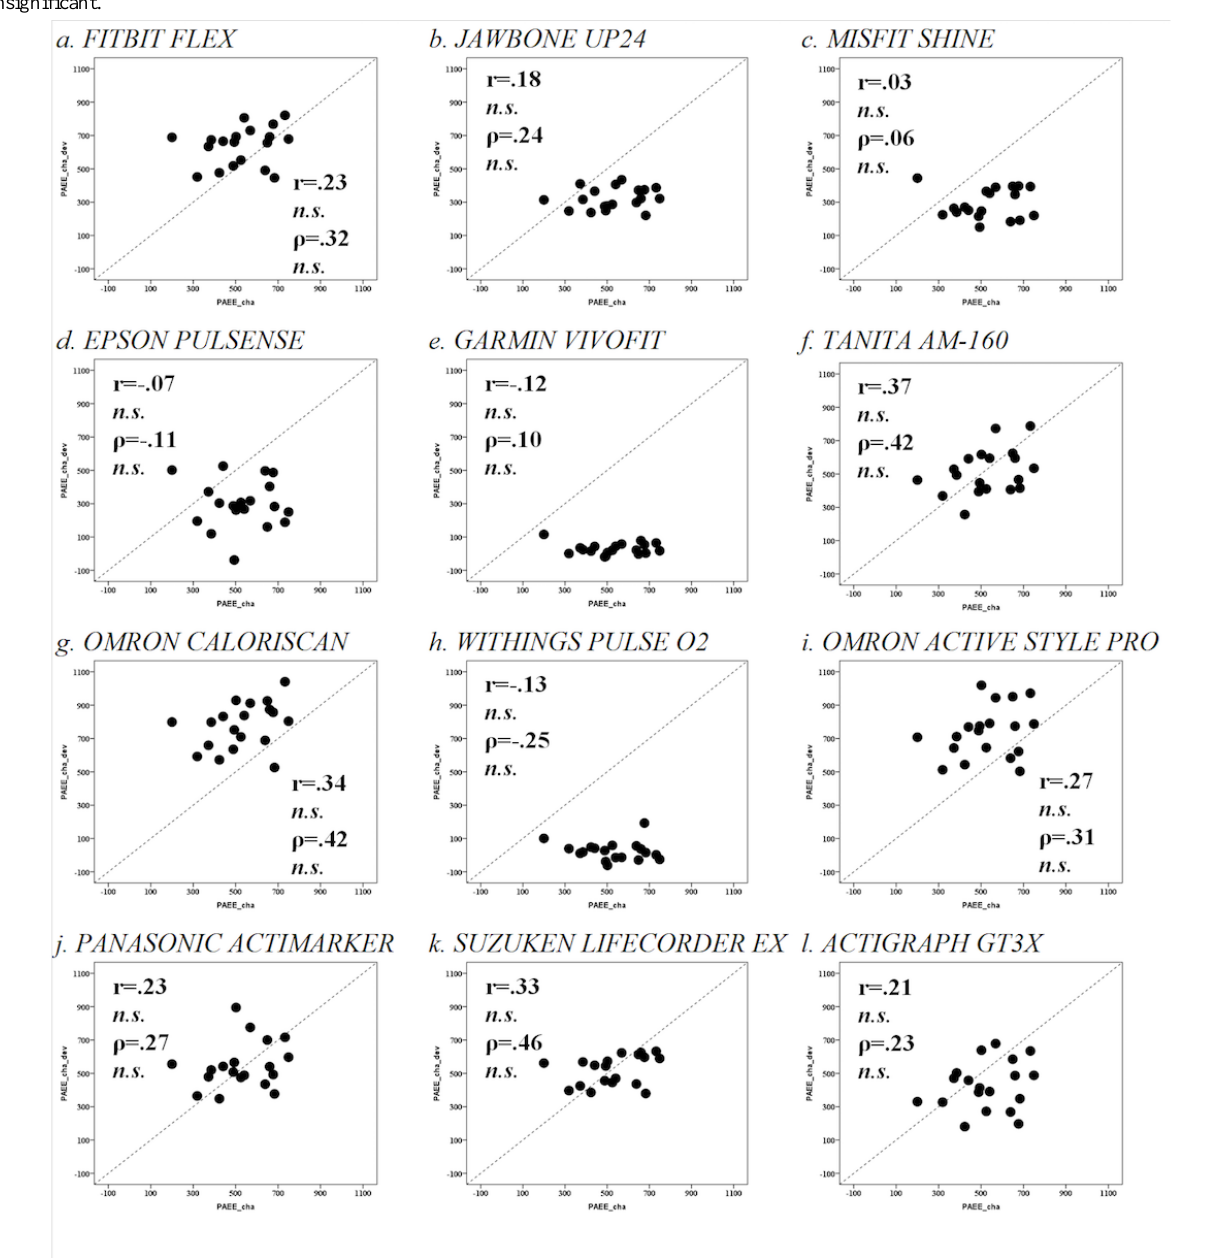
Figure 2. Correlation between PAEEcha (physical activity energy expenditure) and PAEEdev during 1 standardized day. Scattered plots between PAEEcha (x-axis) and PAEEdev (y-axis) during 1 standardized day. There was no significant correlation according to Pearson and Spearman tests. n.s.: